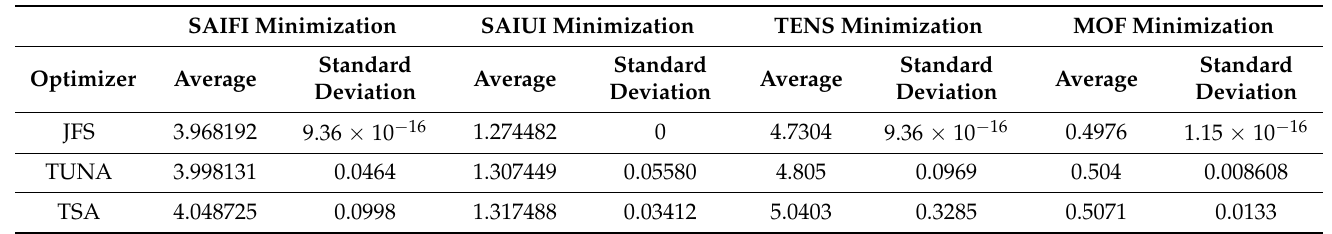
Table 3. SAIFI, SAIUI, TENS and MOF minimization using TUNA, TSA and JFS